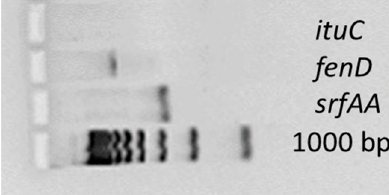
Figure 1. Revealing of the presence of fenD , ituC , and srfAA genes in the genome of B. mojavensis P1709 using PCR with specific primers followed by agarose gel electrophoresis.